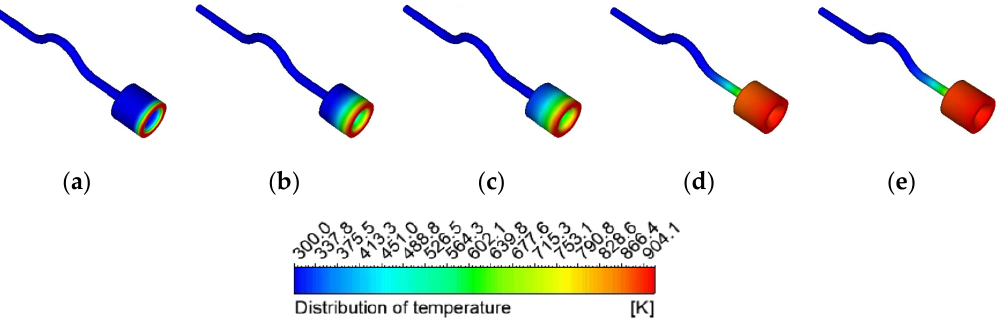
Figure 9. Capillary temperature distribution at different times: ( a ) 0 s ( b ) 0.005 s ( c ) 0.01 s ( d ) 0.1 s ( e ) 0.2 s.